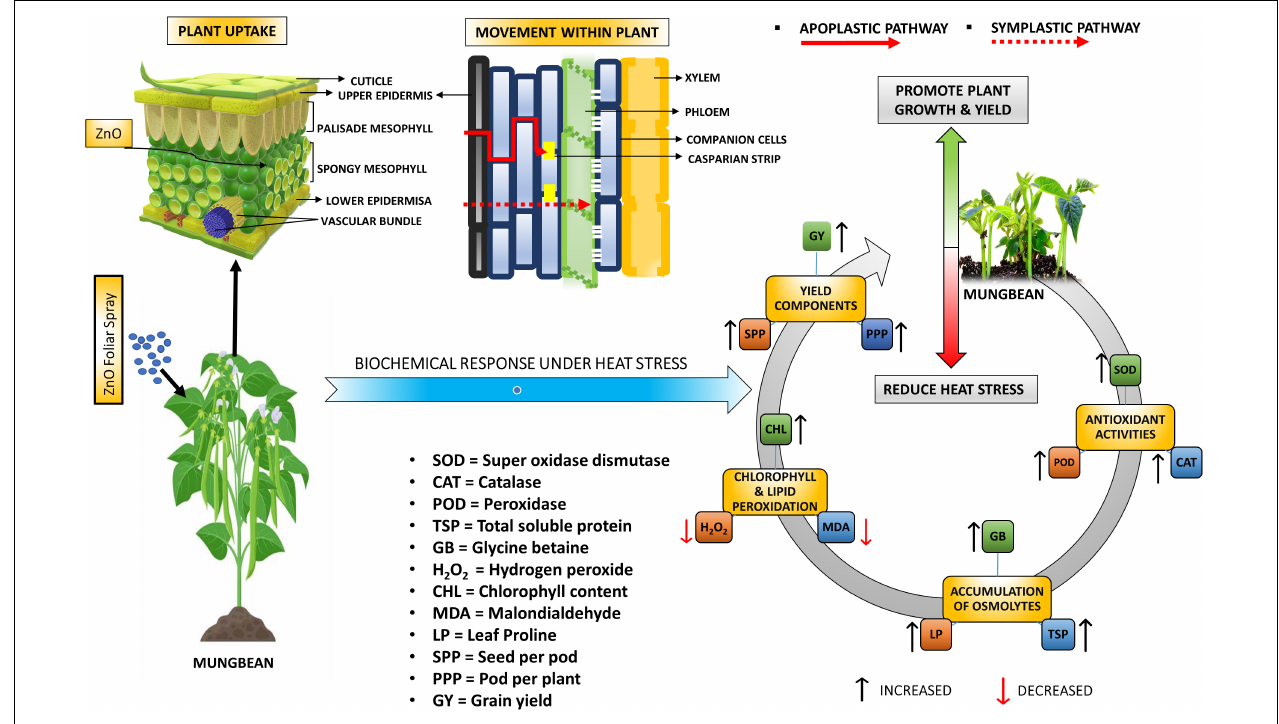
FIGURE 8 | Graphical representation of plant yield and biochemical attributes with foliar-applied nano-ZnO under sowing time generated heat